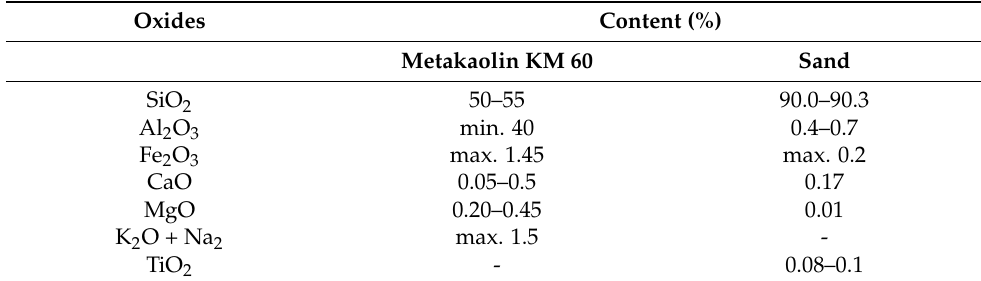
Table 1. The chemical composition of the metakaolin KM 60 and sand.